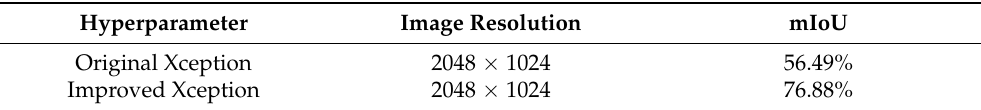
Table 6. Comparison of results with different